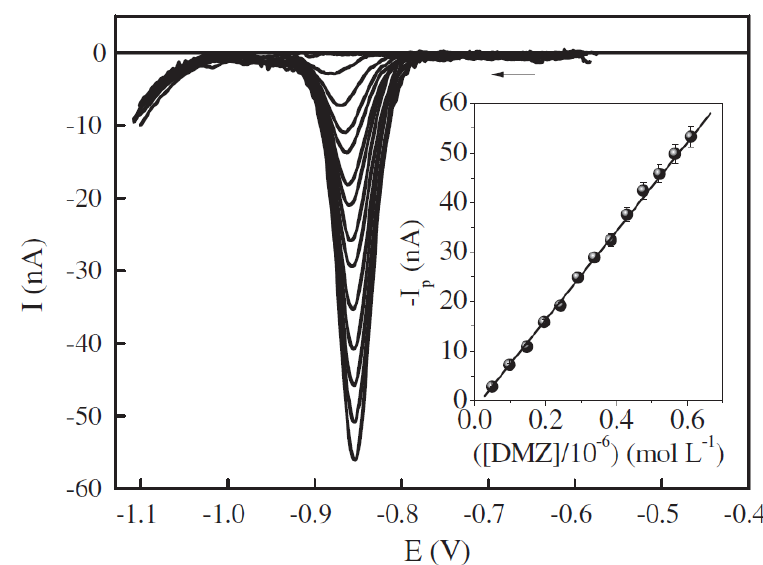
Figure 7. Square-wave voltammograms for DMZ in BR buffer (pH 2.0) on the HMDE with f = 100 s − 1 , a = 15 mV, dEs = 2 mV, E acc = − 0.60 V, t acc = 15 s, and concentrations in the interval from 4.98 × 10 − 8 to 6.10 × 10 − 7 mol L − 1 DMZ. Inset: Analytical curves obtained from voltammograms presented in the main panel. Reprinted from Square-wave adsorptive voltammetry of dexamethasone: Redox mechanism,